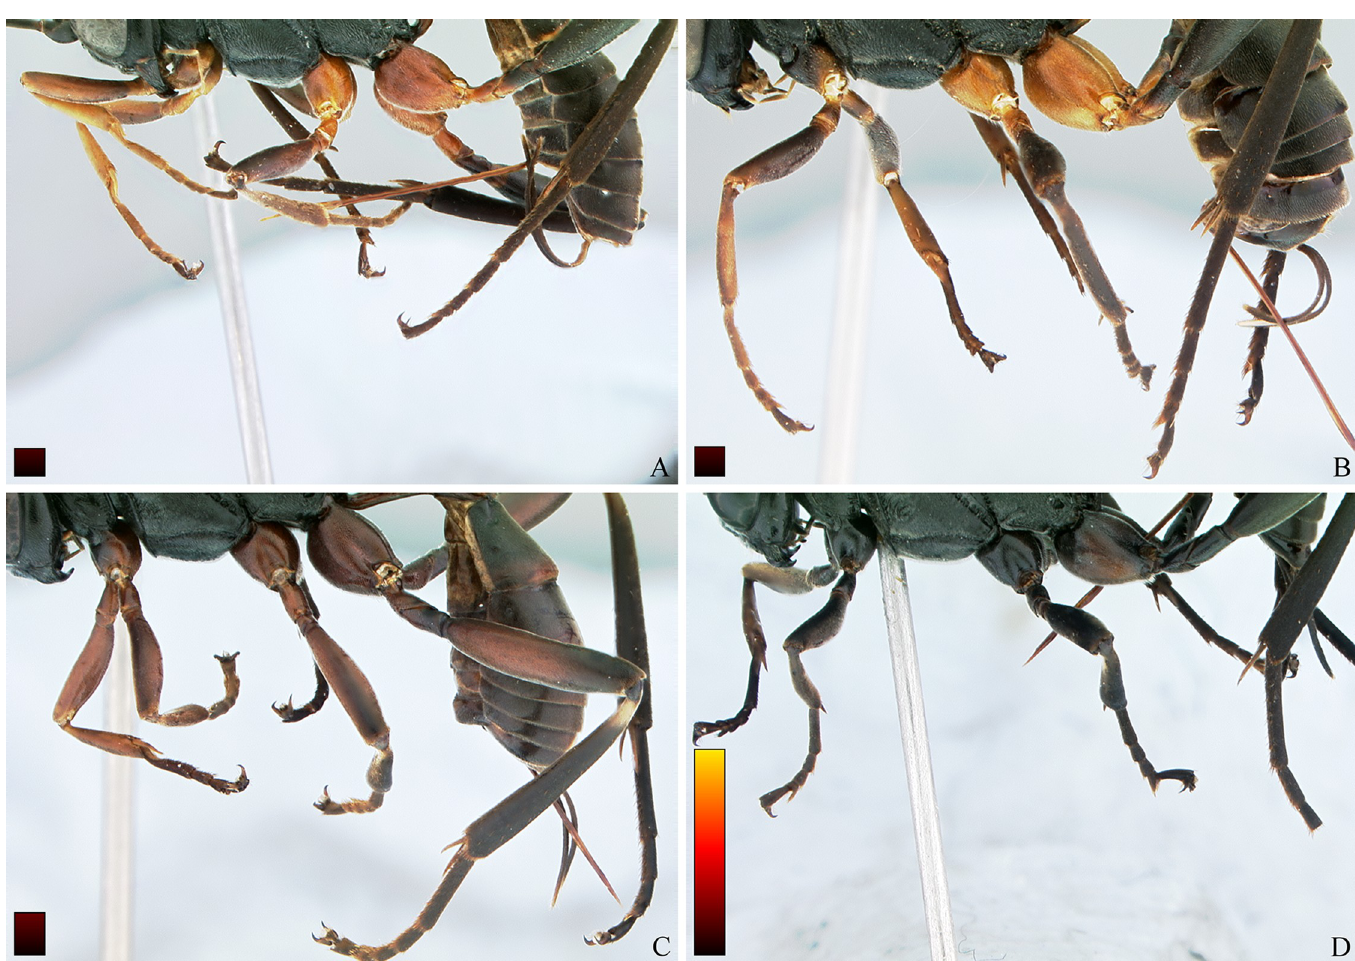
Fig 13. Cryptoxenodon metamorphus sp. nov. from the paratype series. Female legs, left side. (A) FAS4605, Alt. 75m, Colombia. (B) FAS4604, Alt. 80m, French Guiana. (C) UFES45548, Alt. 115m, Brazil/BA. (D) FAS331, Alt. 561m, Brazil/ES. Bars are proportional to the altitude. anteriorward, somewhat v-shaped; ventral outline linear, without projections or flanges. Meta- pleural triangle distinct, not impressed. Posterior margin of metanotum with teeth-like projec- tions. Transverse furrow at base of propodeum, smooth. Juxtacoxal carina present and distinct, even if incomplete. Pleural carina from weak and incomplete to distinct and complete. Fore tibia normal, not swollen or basally constricted; fourth tarsomeres distinctly bilobed, approximately of equal length. Hind fifth tarsomere without midventral bristles. PROPODEUM . Anterior margin linear, with teeth-like projections or tubercles; anterior area outline regular, not raised, in lateral view at the same level as the rest of propodeum. Pro- podeal spiracle distinctly elliptic. Anterior transverse carina distinct, strongly bent anteriad at median portion. Posterior transverse carina absent; posterior sublateral portion of propodeum produced as a conspicuous tubercle. Median longitudinal carina absent. Lateral longitudinal carina absent. WINGS . Forewing hyaline to moderately infuscate, sometimes with 1–2 dark spots, even if weak; short vein projection (ramellus) at junction of forewing veins 1m-cu and 1-Rs+M from completely absent to present, long; crossvein 1cu-a from basad to slightly apicad base of